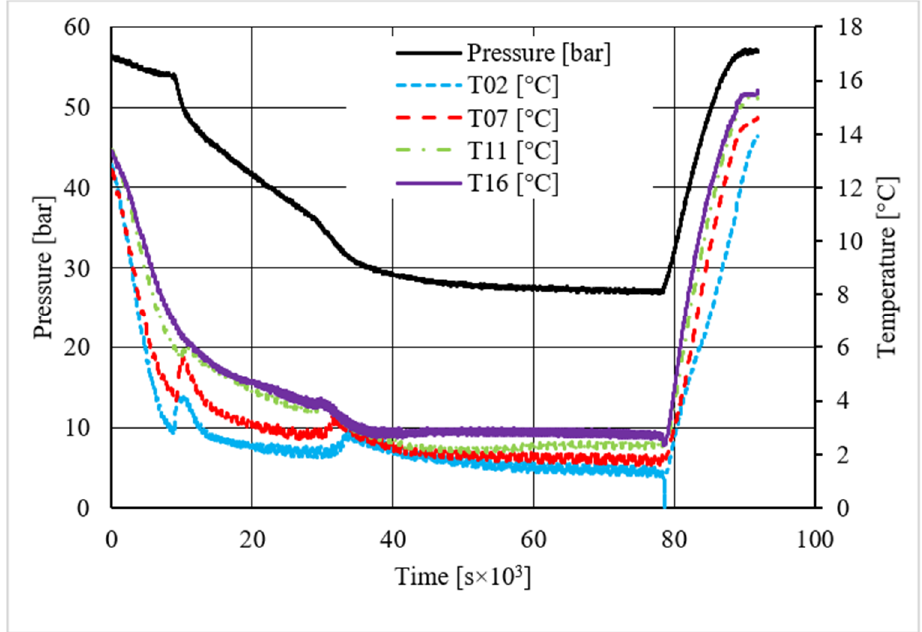
Figure 10. Pressure vs. temperature, describing methane hydrate formation in the presence of 18.01 wt.% CuSn12 powder.